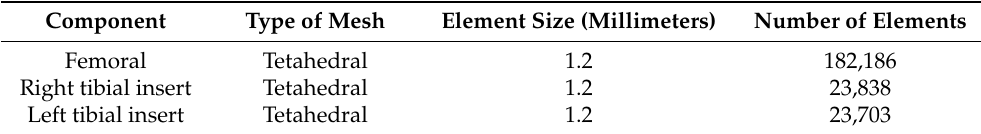
Figure 2. ( a ) The boundary and loading conditions of the FE model. ( b ) FE model of the knee implant. Table 3. Mesh parameters of the BCR TKA knee implant model for each component.